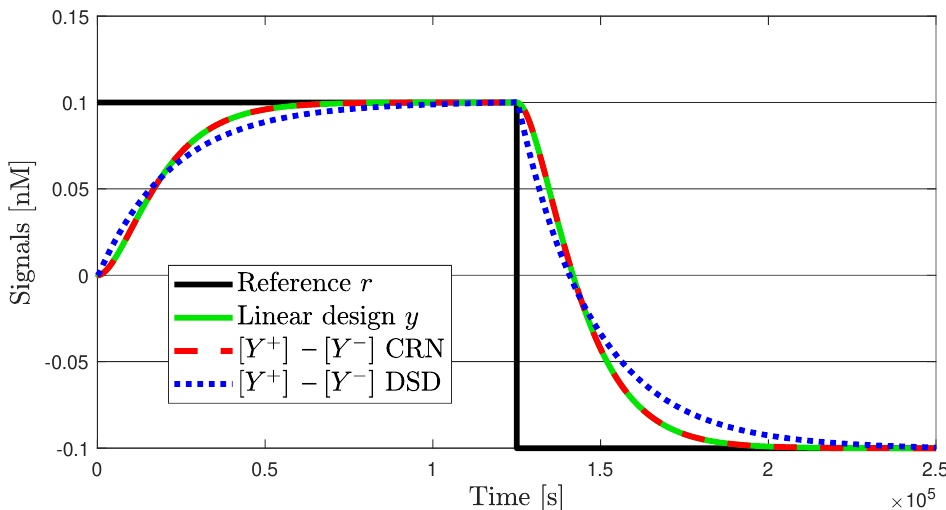
Figure 14. The state feedback control (Example 4) simulation results: steady-state tracking response of the linear design and the CRN and DSD reactions representing the I/O